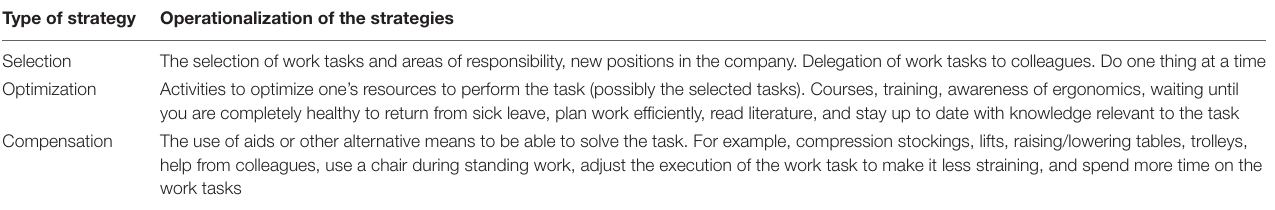
TABLE 2 | Overview of the number of occurrences of SOC strategies at each of the organizational levels in the data.